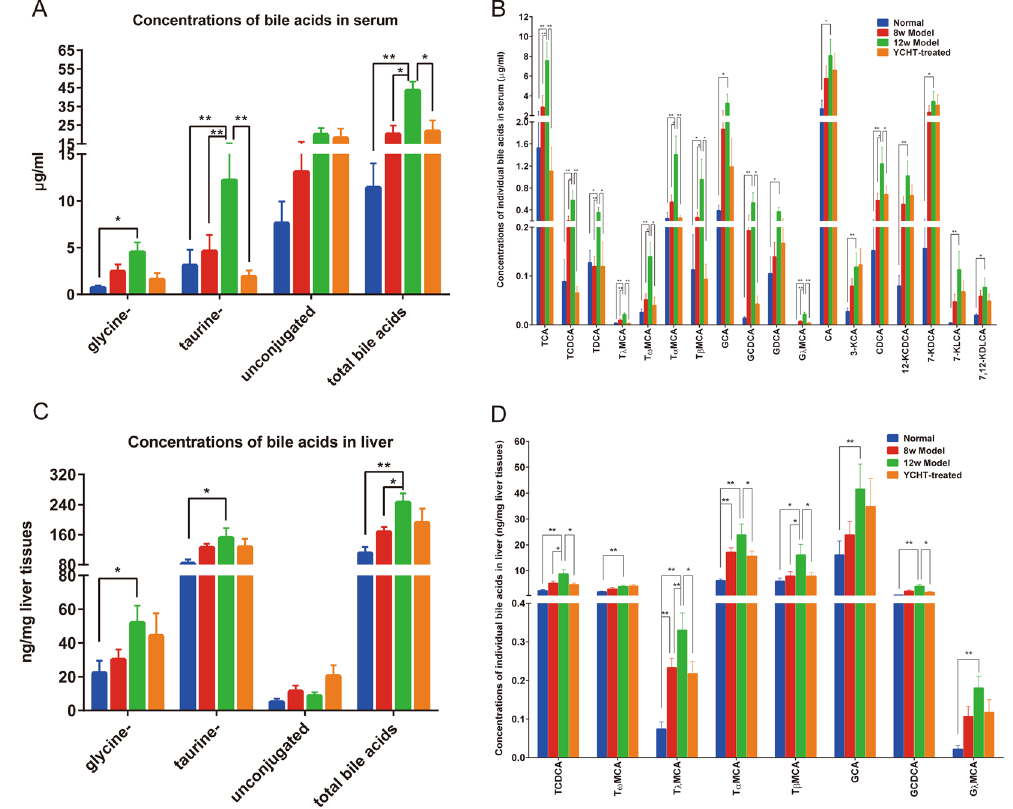
Figure 4. ANIT induced significant alteration of BA profile in serum and liver (mean ± SEM). ( A ) Concentrations of unconjugated, taurine-conjugated, glycine-conjugated BAs and total BAs in serum, ( B ) Concentrations of individual BAs in serum, ( C ) Concentrations of unconjugated, taurine-conjugated, glycine- conjugated BAs and total BAs in the liver, and ( D ) Concentrations of individual BAs in the liver. Data are presented as mean ± SEM of 5–9 rats. * P < 0.05, ** P <